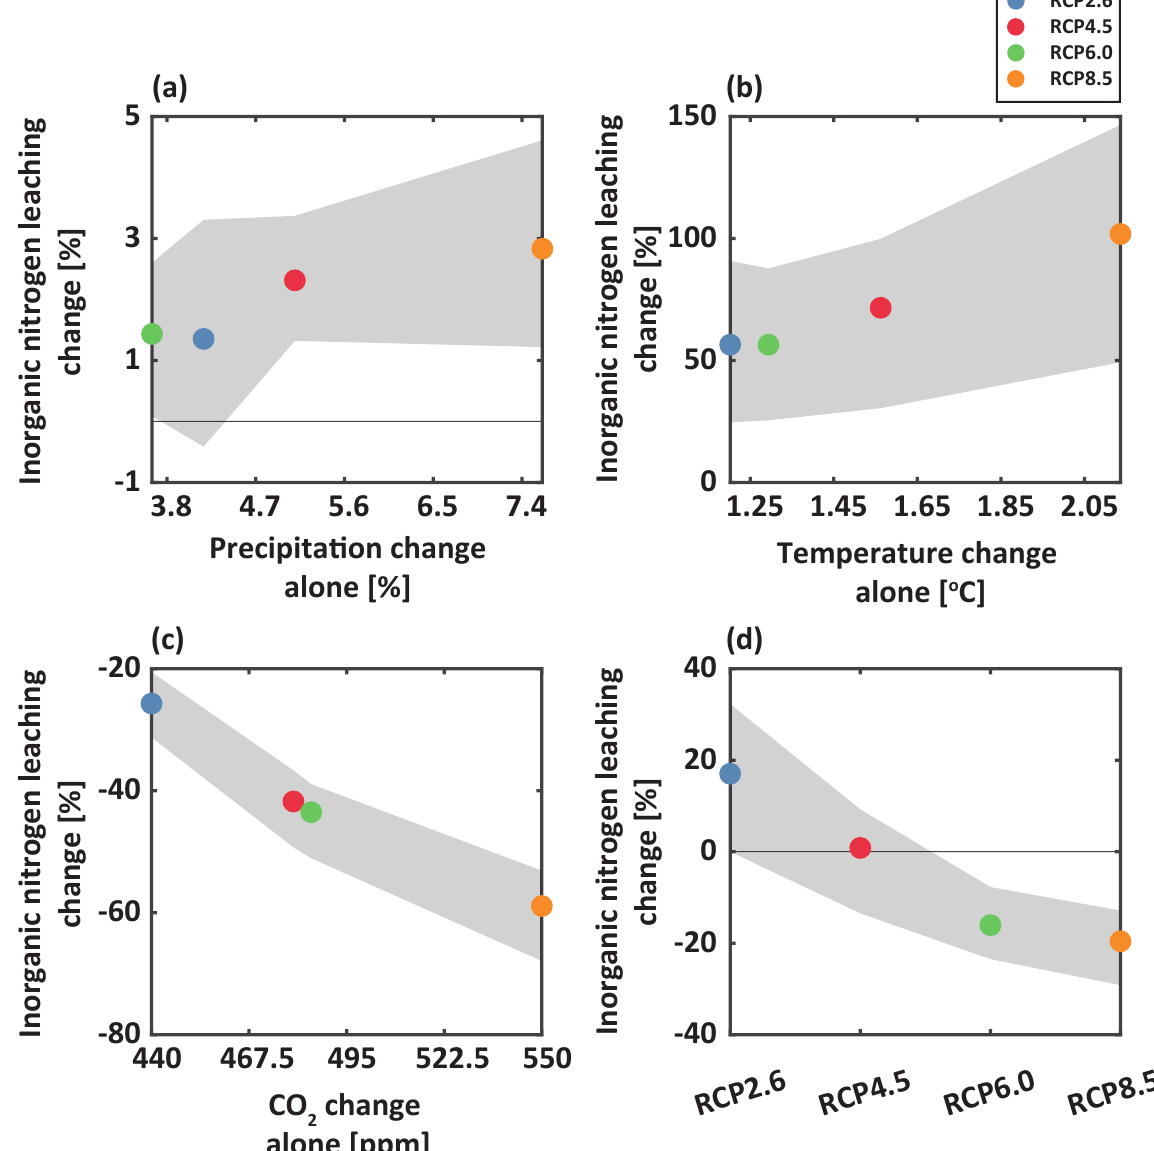
Figure 5. Percent changes in projected inorganic leaching at a depth of 3m compared with baseline for the scenario of ( a ) precipitation change alone, ( b ) temperature change alone, ( c ) CO 2 change alone, and ( d ) all together under RCP 2.6 (blue), 4.5 (red), 6.0 (green), and 8.5 (orange) for the 2050s (from 2036 to 2065). Shaded areas represent the 25th to 75th percentile